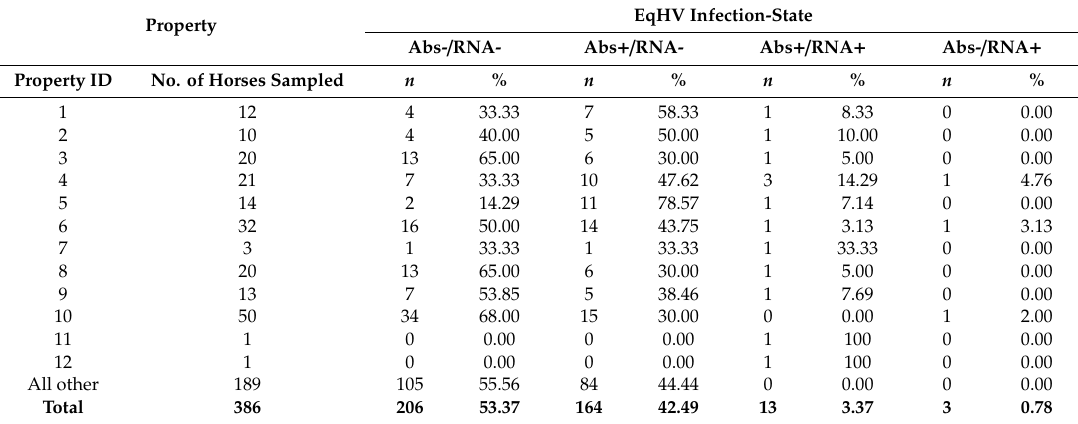
Table 1. Information pertaining to the 12 properties where EqHV RNA-positive horses were identified, including the EqHV infection-state of the sampled